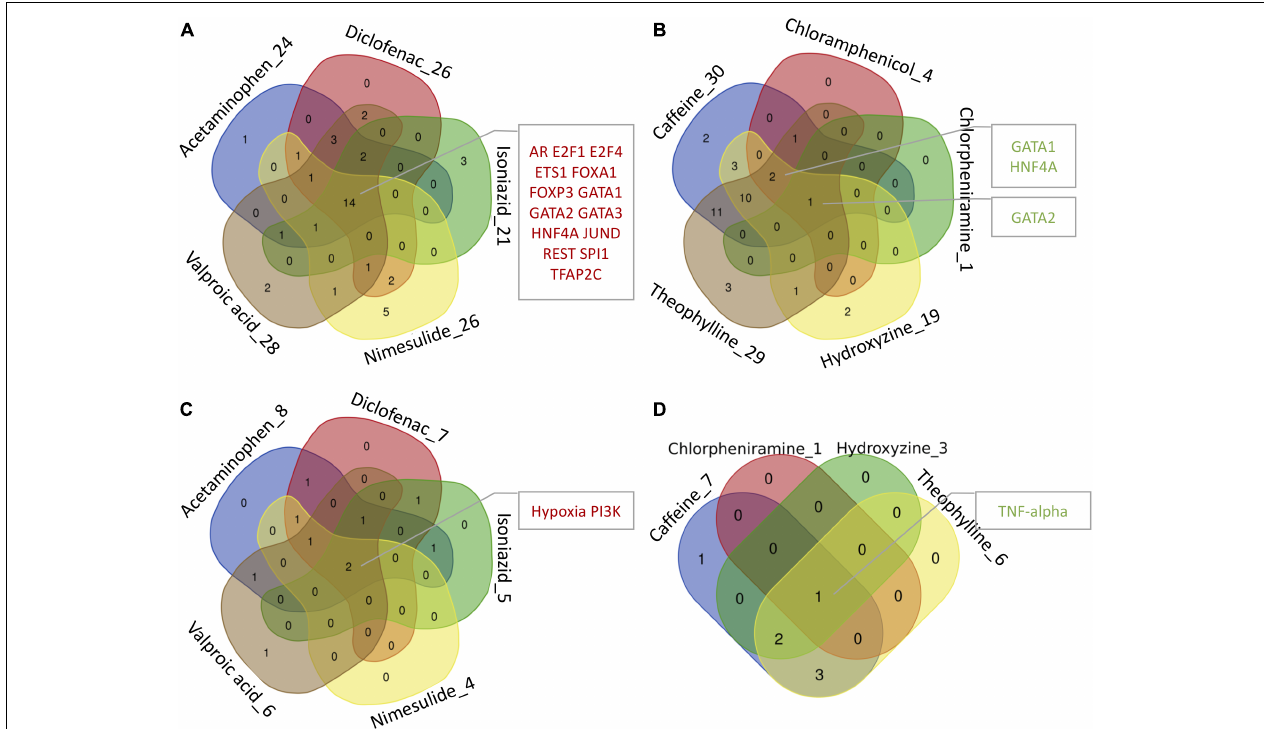
FIGURE 2 | Venn diagrams showing the intersection of transcription factors (TFs) and signaling pathways regulating at least one dark gene. The number accompanying each compound refers to the number of transcription factors and signaling pathways enriched by dark genes and the intersected modules by all or most of the compounds are highlighted in the adjacent boxes. (A,B) Regulatory TFs of hepatotoxic and non-hepatotoxic compounds, respectively. (C,D) Regulatory signaling pathways of hepatotoxic and non-hepatotoxic compounds, respectively. No enriched signaling pathway was found for Chloramphenicol (absent in D ).